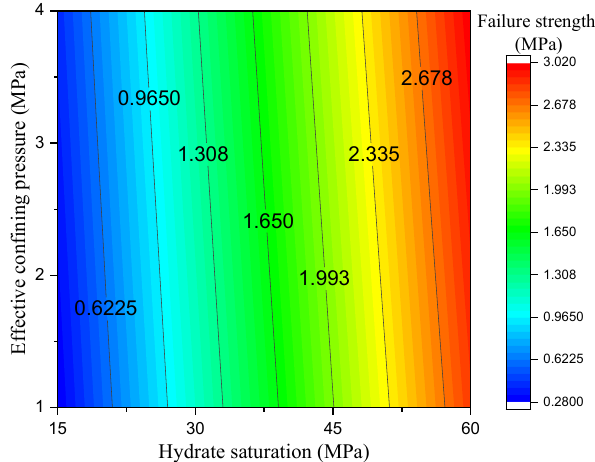
Figure 11. Calculation failure strength with this proposed model.